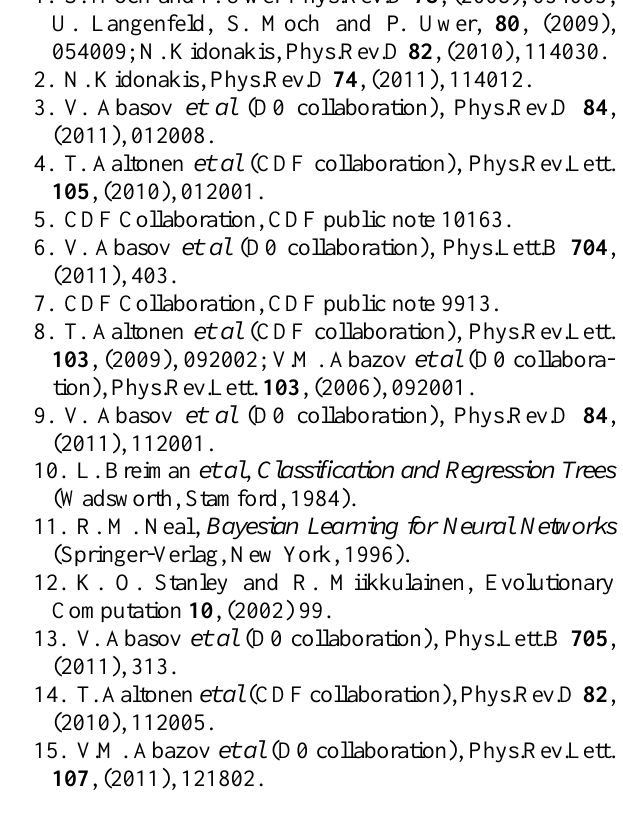
Fig. 7. Number of b -tagged jets in ℓ + jets events with